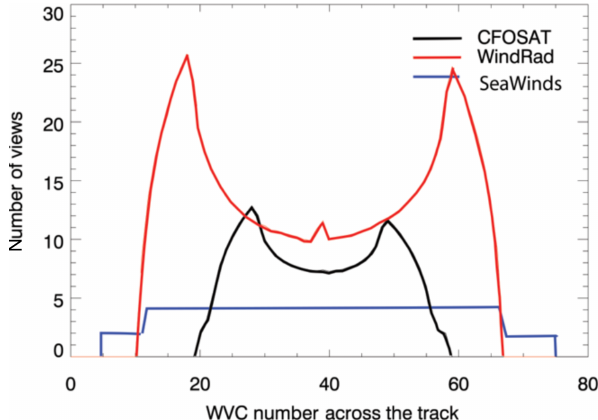
Figure 10. Averaged number of views at the WVCs across the